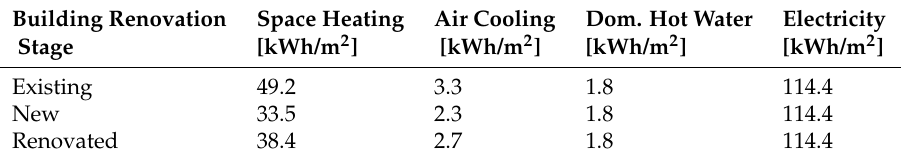
Figure A4. Hourly specific energy service demand of commercial buildings. Table A21. Yearly specific energy service demand of commercial